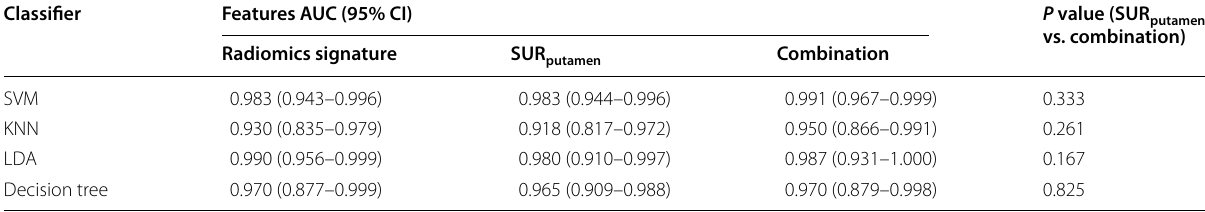
SVM support vector machine , KNN k-nearest neighbour , LDA linear discriminant analysis , SUR striatum uptake ratio, AUC area under the curve, CI confidence interval